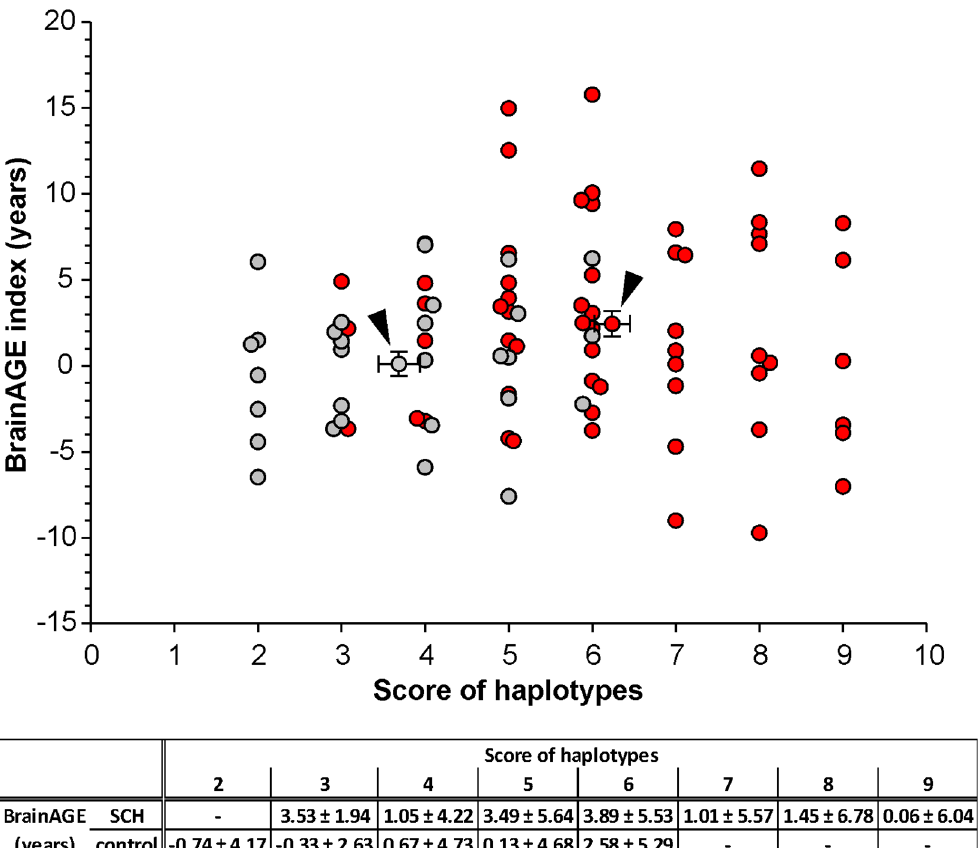
Figure 4. BrainAGE index and haplotype scoring model. The graph shows the distribution of haplotype scores and BrainAGE indexes in both groups; SCH (red) and controls (gray). The arrows mark the mean haplotype score 6.27 ± 1.58 and mean BrainAGE index 2.44 ± 5.54 in SCH, and score 3.69 ± 1.40 and BrainAGE 0.14 ± 3.94 in controls, respectively. The bottom table shows the mean values of BrainAGE index for each scores in both groups.